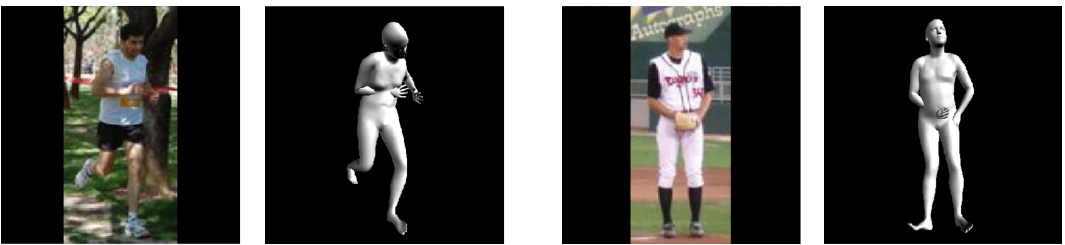
Figure 1. Examples of model-based 3D pose estimation results with self-intersection between body